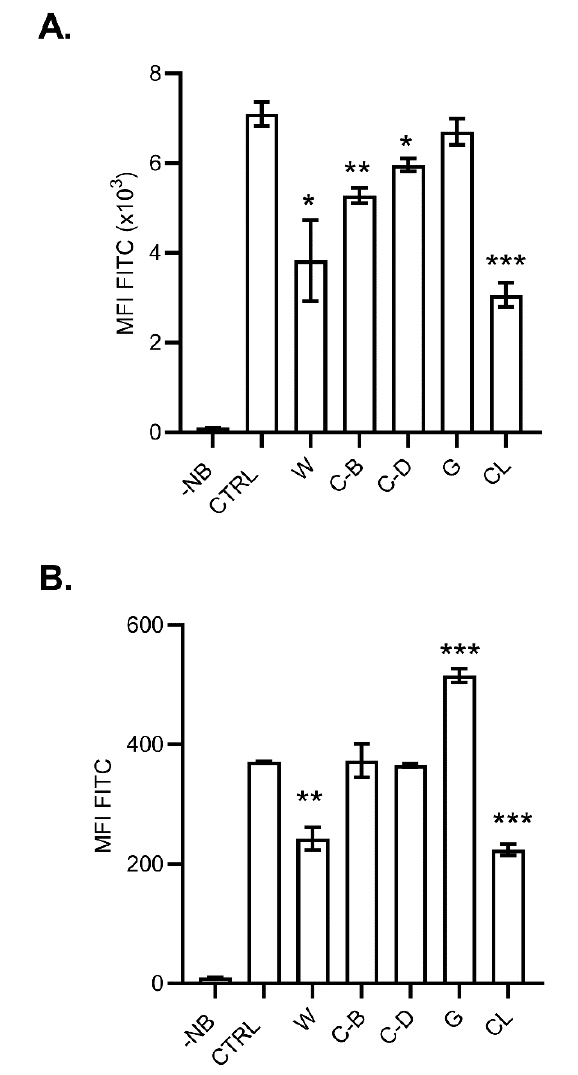
Figure 9. E ff ects of inhibitors in the FITC-NanoMBG incorporation by cells. Graphs showing the median of fluorescence intensity (MFI) in DC2.4 dendritic cell line ( A ) or Th2 CD4 + SR.D10 cell line ( B ) cultured for 2 h in the presence of NanoMBGs plus inhibitors as wortmannin (W), cytochalasin B (C-B), cytochalasin D (C-D), genistein (G) or chlorpromazine (CL) as described in the Methods section. CTRL, control without inhibitor; -NB, cells alone. Data from one representative experiment out of three, each with triplicates are shown. Asterisks (* p < 0.05; ** p < 0.01; *** p < 0.001) indicate significant di ff erences as compared to CTRL without inhibitor.